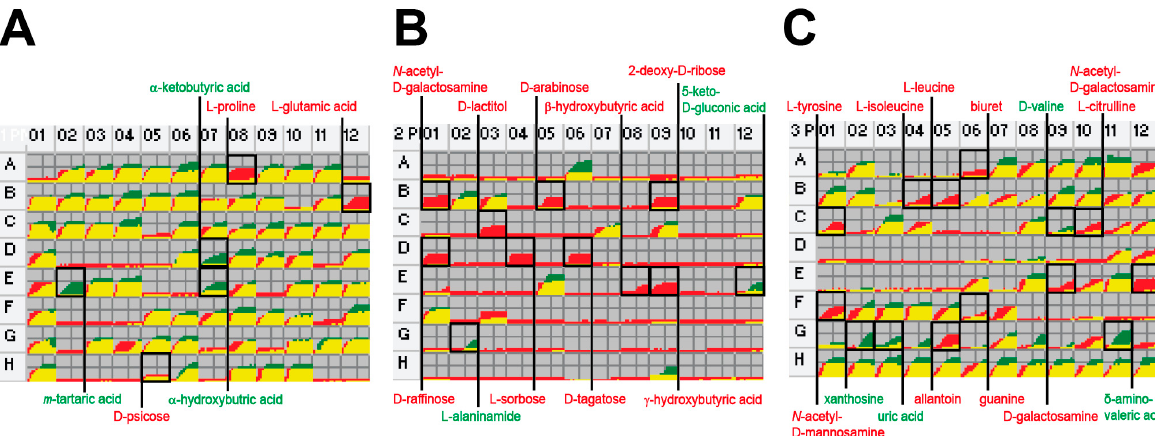
Figure 2. Comparison of carbon and nitrogen source utilization of E. coli strains Nissle 1917 and K-12 MG1655. Growth curves in all the cells are shown for E. coli Nissle 1917 (red) and K-12 MG1655 (green). ( A ) Carbon sources (PM1). ( B ) Carbon sources (PM2). ( C ) Nitrogen sources (PM3).